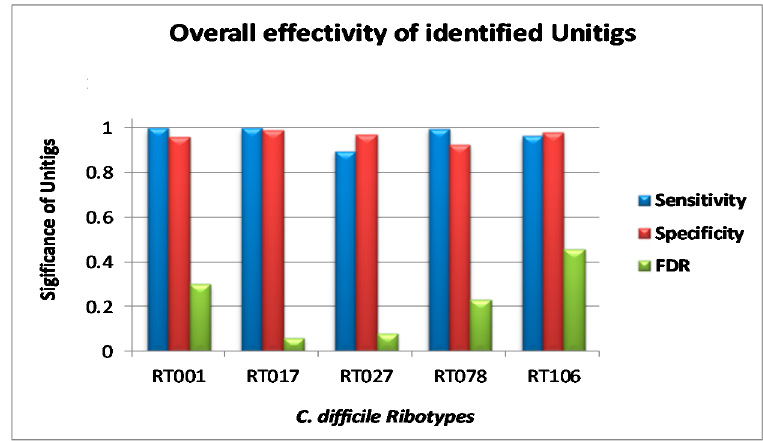
Figure 3. Statistical comparison of genome typing efficiency of discovered unique patterns for selected C. difficile ribotypes in terms of specificity, sensitivity, and false discovery rate (FDR).